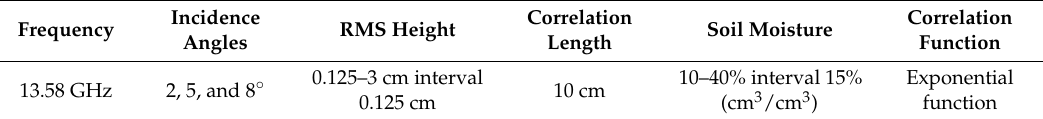
Table 2. Input parameters of theoretical